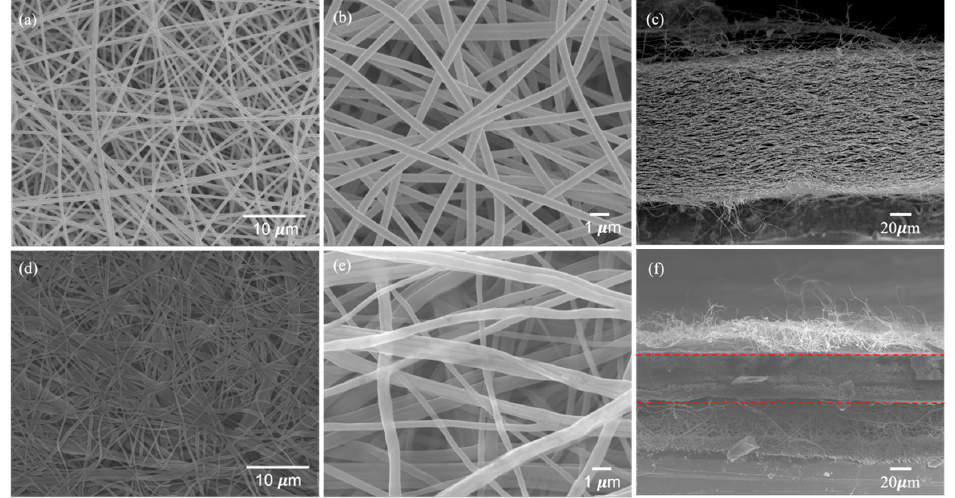
Figure 5. Morphologies of non-hot-pressed BI-PI separator membrane ( a , b ) surface, ( c ) cross-section type, hot-pressed one ( d , e ) surface, and ( f ) cross-section.